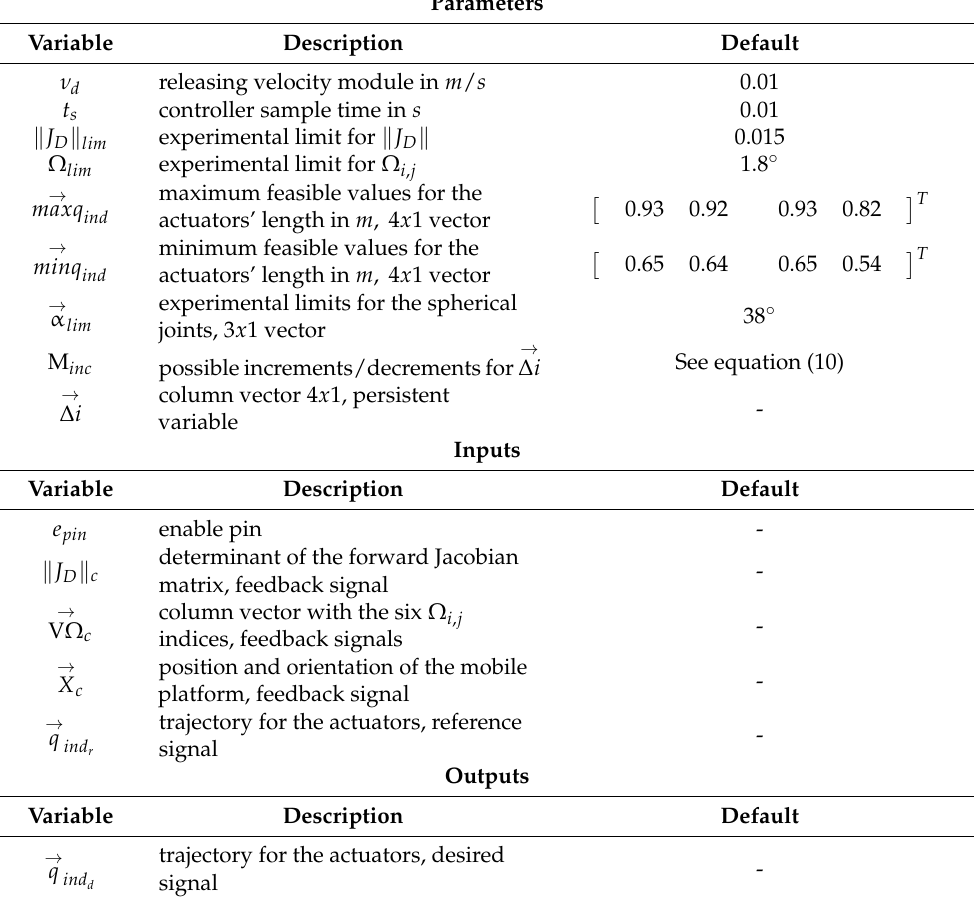
Table 2. Description of parameters, inputs, and outputs of SRM-V1 and SRM-V2.